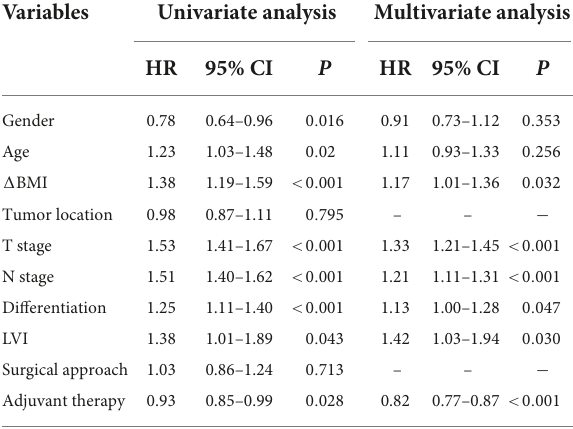
TABLE 3 Cox regression analyses of survival for 1,883 patients with esophageal